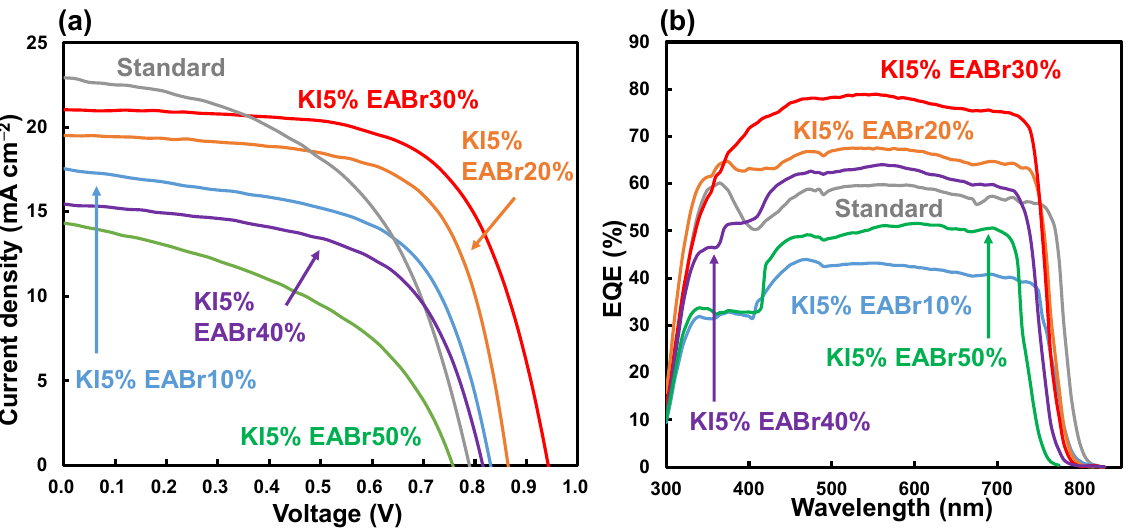
Figure 2. ( a ) J-V characteristics and ( b ) EQE of perovskite solar cells that contained KI- and EABr- doped perovskite. Table 1. Measured photovoltaic parameters of the present perovskite solar cells.